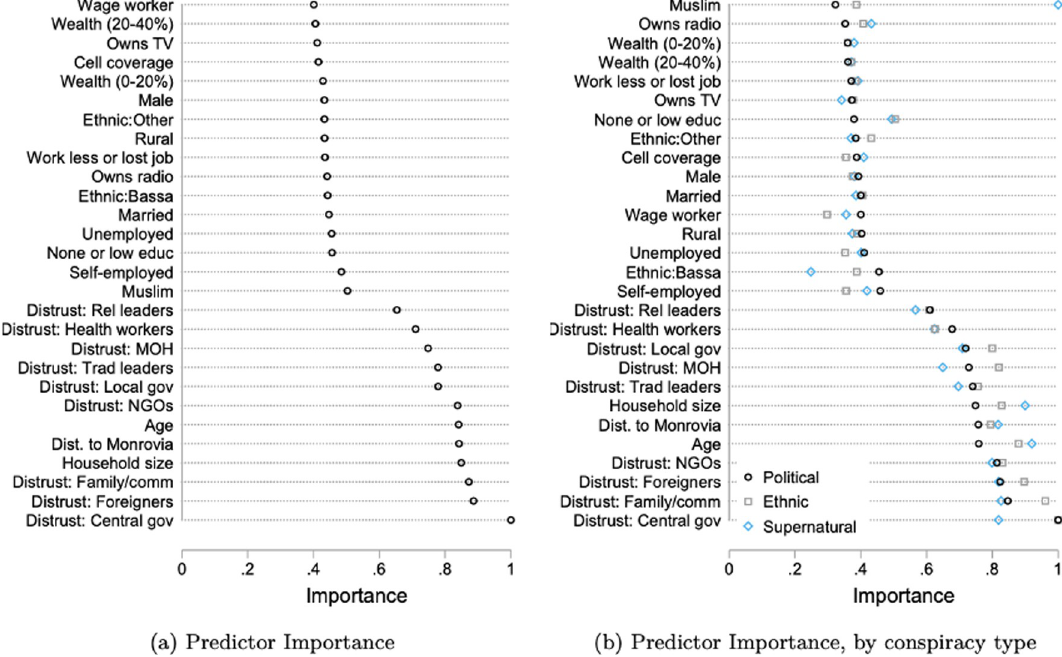
Fig 2. Random Forests (RF) predictor importance. Dots represent the importance score (from 0 to 1) of the predictors for being misinformed from Random Forests. Panel (b) presents the determinants of misinformation by type. “Political” refers to individuals reporting the government was responsible for bringing Ebola “Ethnic” refers to individuals reporting foreign NGOs, UNMIL, White, Fula, Kissi, or Mandingo people bringing Ebola. “Supernatural” refers to individuals reporting that God or witches were responsible for bringing Ebola. Refer to Fig 1 notes for a description of the